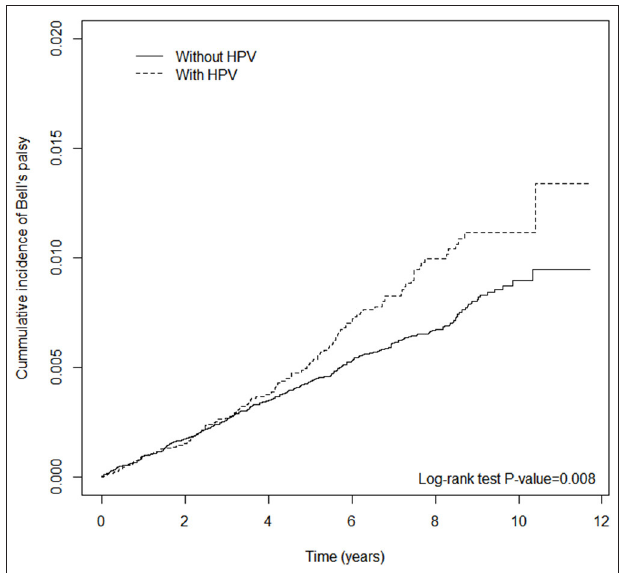
FIGURE 2 | Cumulative incidence of Bell’s palsy for the human papillomavirus (HPV) and the